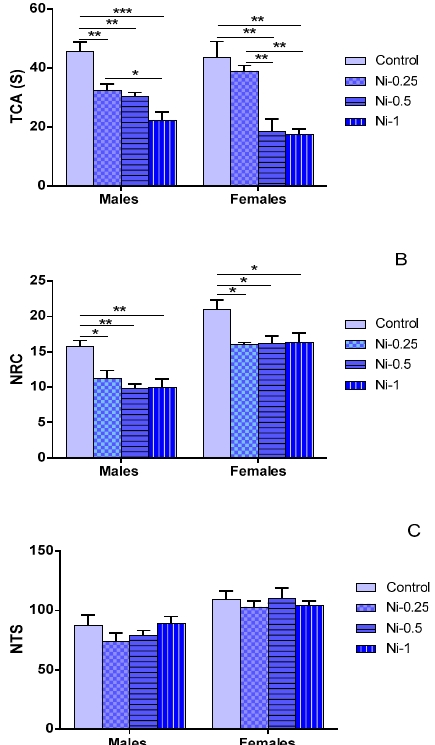
Figure 1. ( A ) Total amount time spent in the center (TCA); ( B ) Number of return into center area of the arena in the open-field behavior apparatus (NRC); and ( C ) Number of total squares (NTS) in the open field in female and male rats after 2 month of treatment with 0.9% of NaCl (Control), 0.25 mg/kg (Ni-0.25), 0.5 mg/kg (Ni-0.5), and 1 mg/Kg (Ni-1) of Ni. Results are expressed as mean ± SEM. The significance level is 0.05. * p < 0.05, ** p < 0.01, *** p < 0.001.